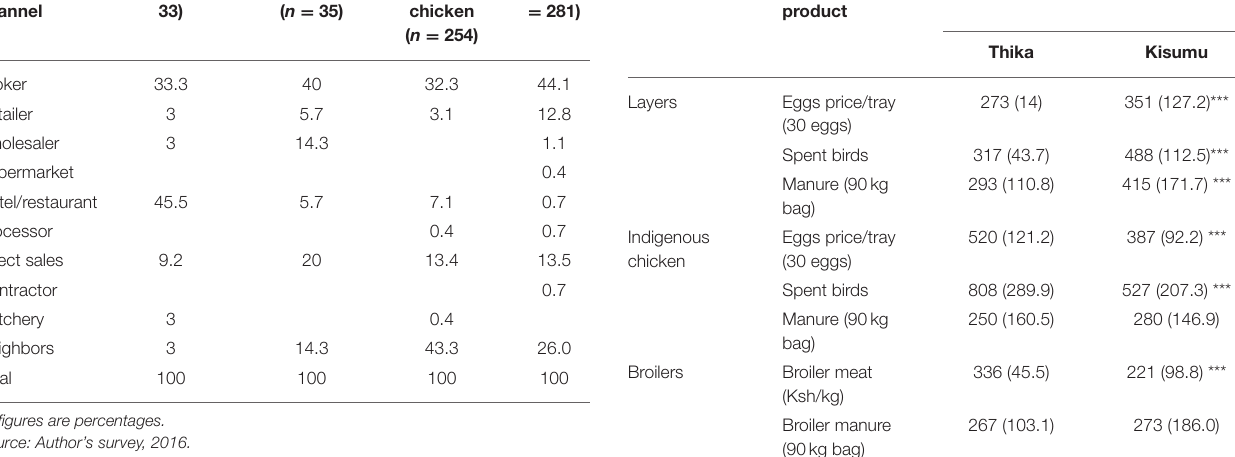
TABLE 4 | Mean prices of poultry products/by-products in Thika and Kisumu, 2016. Enterprise Type of product